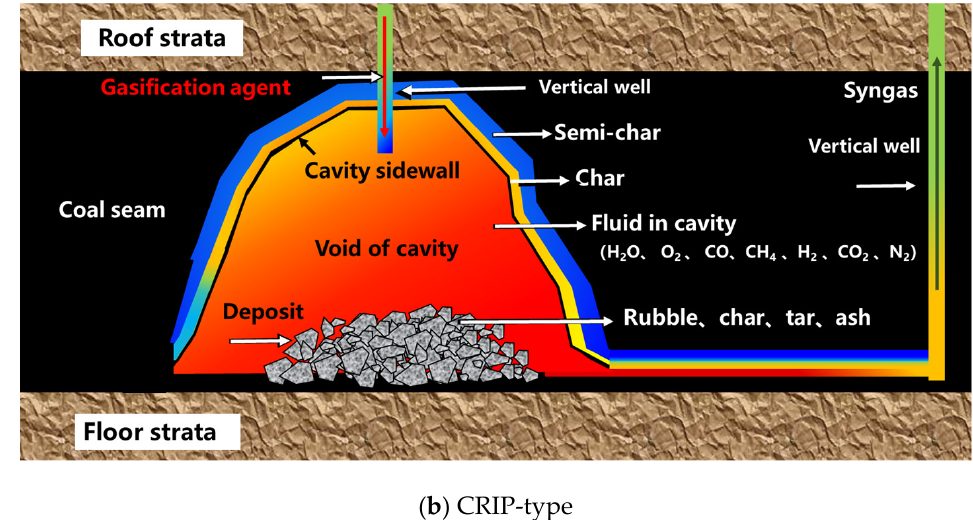
Figure 1. Schematic diagram of the drilling-type UCG mode (modified from [7]).